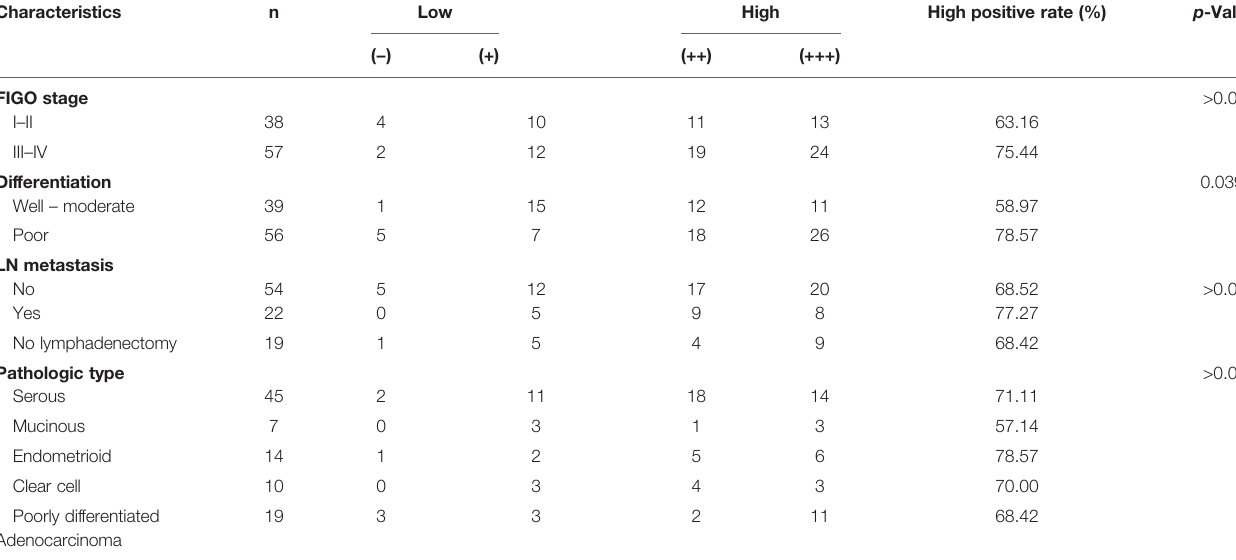
TABLE 1 | Relationship between RAD21 expression level in epithelial ovarian cancer and clinicopathological parameters. Characteristics